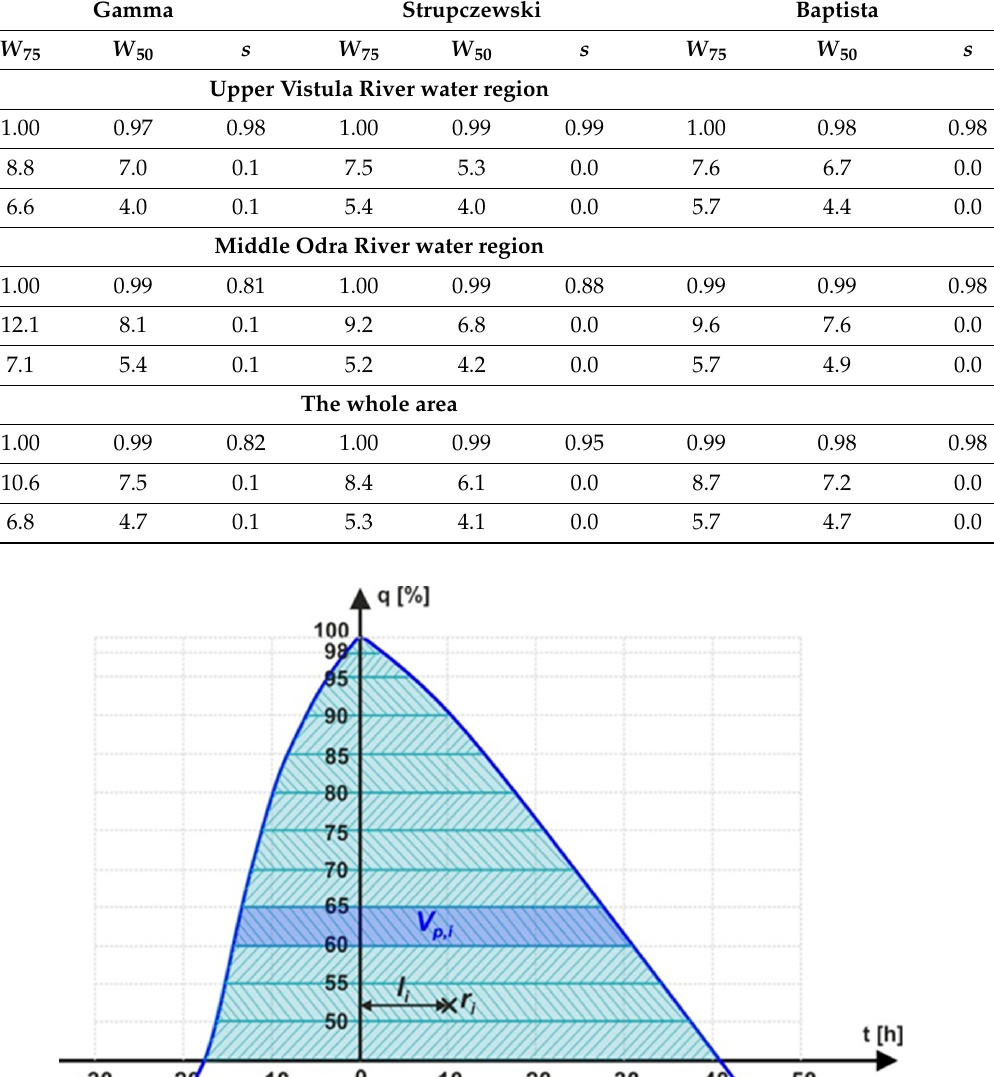
Table 3. The values of statistical measures: correlation coefficient ( r ), root mean square error ( RMSE ) and mean absolute error ( MAE ) for DFH characteristics W 50 , W 75 and s estimated with the use of the analyzed methods, Gamma, Strupczewski and Baptista, for the upper Vistula River water region, middle Odra River water region and both water regions.